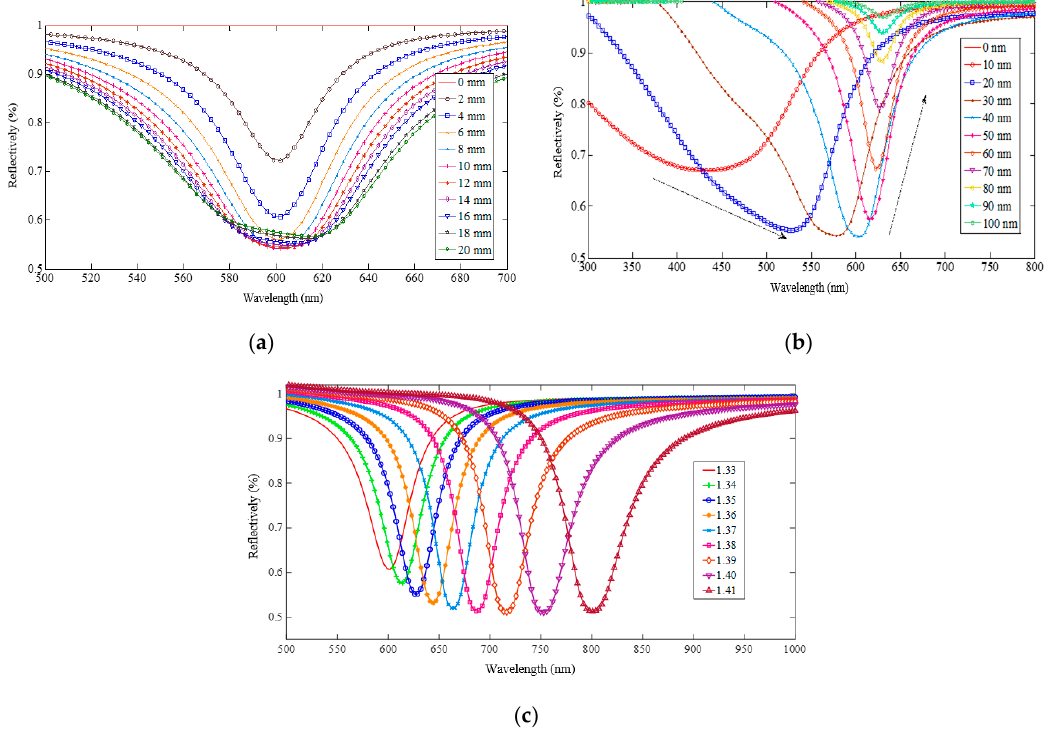
Figure 2. Variation of the simulated SPR spectra along with the changes of the gold film length ( a ), gold film thickness ( b ), and surrounding refractive index ( c ).